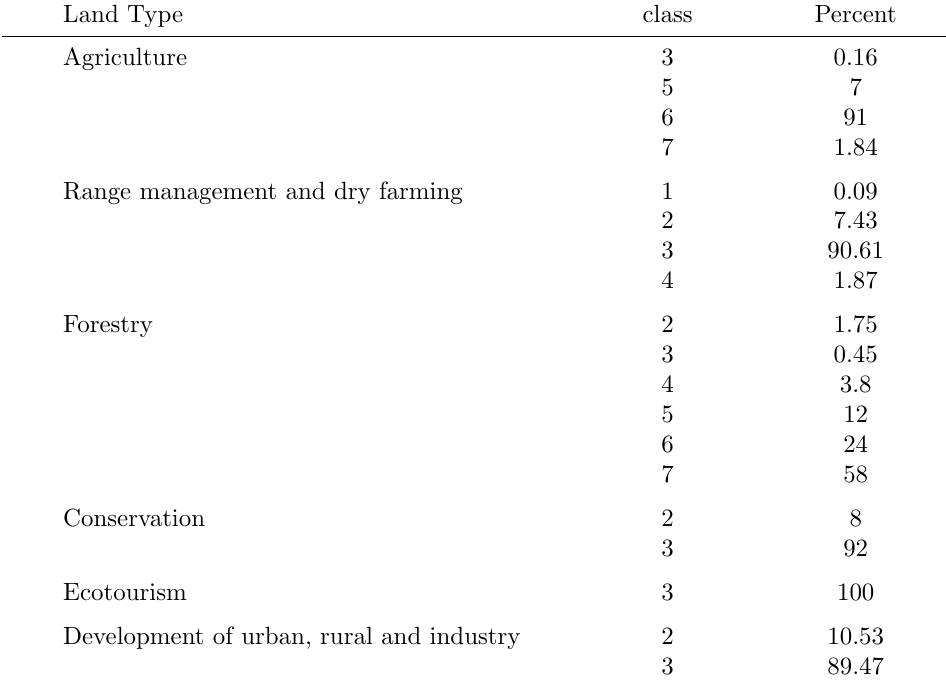
Table 3: Percent of area for different ecological capabilities of land uses Land Type